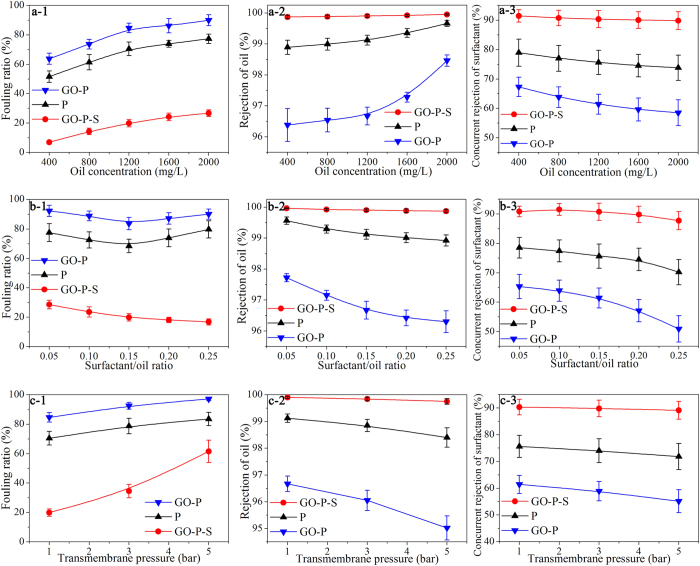
Membrane separation of oil-in-water nanoemulsion.(a-1) Fouling ratios, (a-2) oil rejections, and (a-3) concurrent rejections of surfactant under different oil concentrations, respectively (surfactant/oil ratio is kept as 0.15 and transmembrane pressure is 1 bar). (b-1) Fouling ratios, (b-2) oil rejections, and (b-3) concurrent rejections of surfactant under different surfactant/oil ratios, respectively (oil concentration is kept as 1200 mg/L and transmembrane pressure is 1 bar). (c-1) Fouling ratios, (c-2) oil rejections, (c-3) concurrent rejections of surfactant under different transmembrane pressures, respectively (oil concentration is 1200 mg/L and surfactant/oil ratio is 0.15).